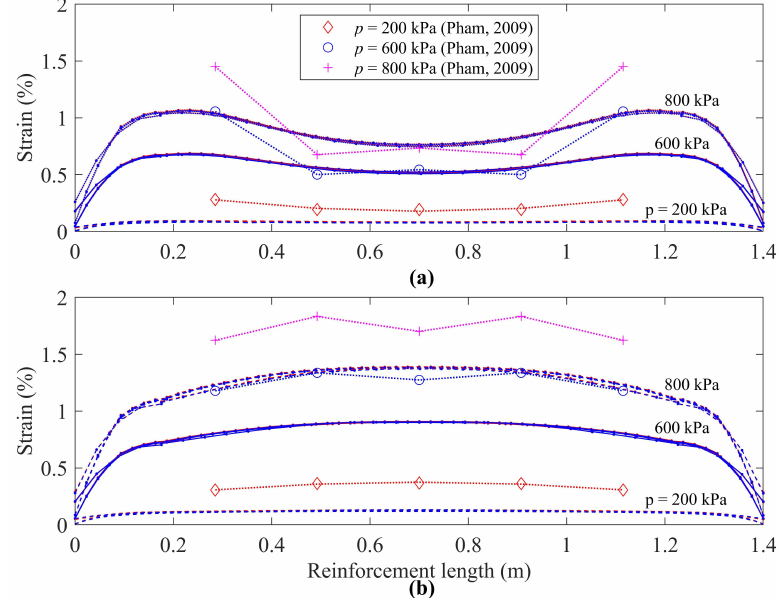
Figure 5. Effect of surcharge loads ( p = 200, 600, 800 kPa) on reinforcement strains of SGC mass, under compaction procedures Type-I, II and III and q of 44 and 70 kPa—for reinforcements at depths: ( a ) 0.4 m; and ( b ) 1.2 m, from the top